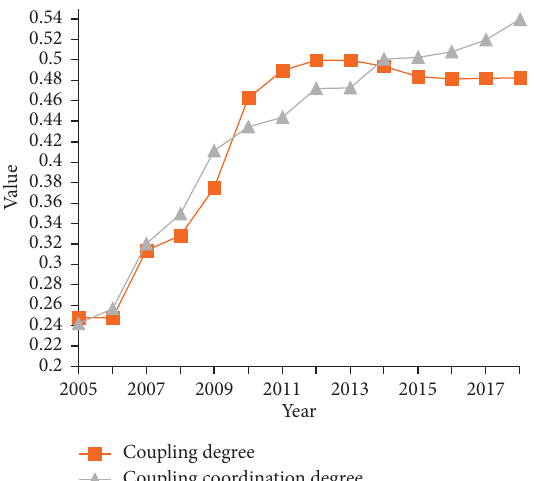
Figure 1: Coupling degree and coupling coordination degree of China’s tourism industry development and the ecological environment in